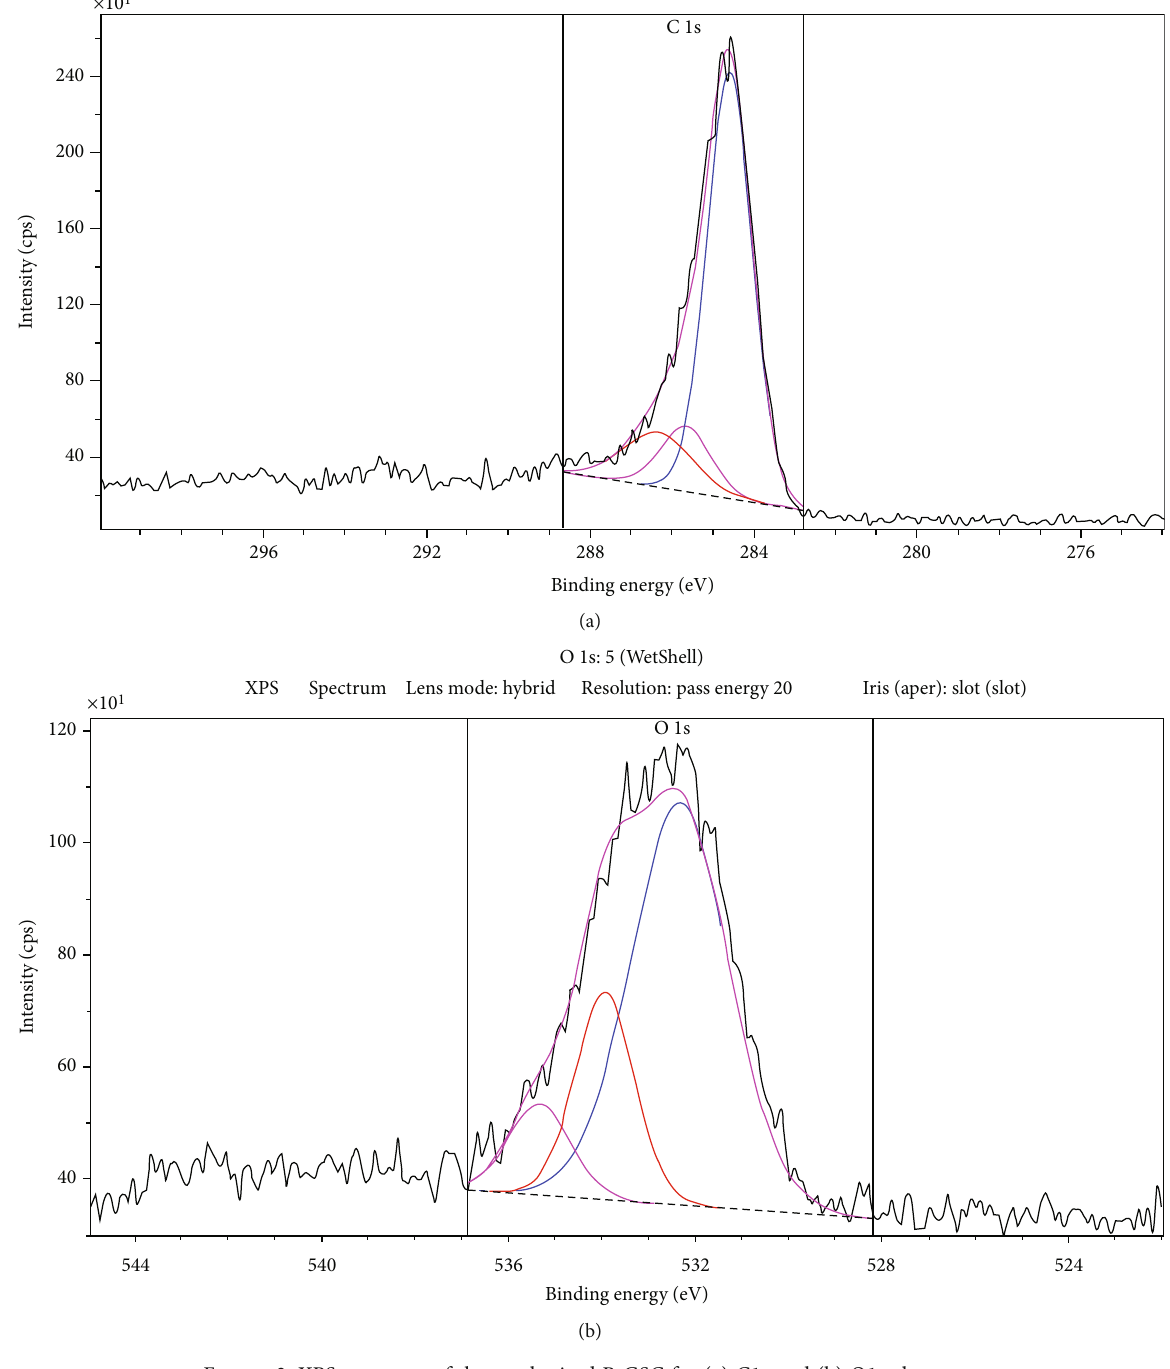
Figure 2: XPS spectrum of the synthesized P-GSC for (a) C1s and (b) O1s